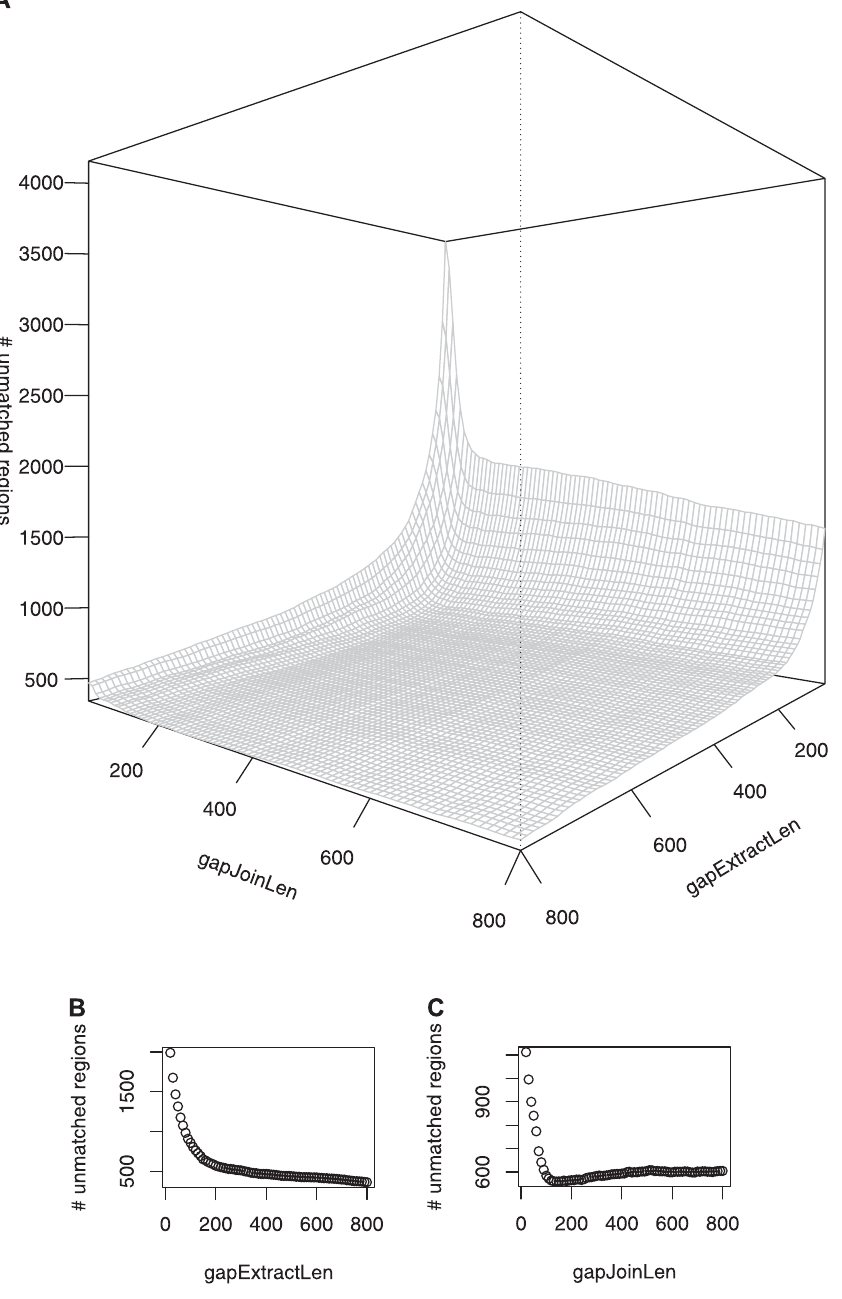
Figure 7. Number of Detected Unmatched Regions in Step 3 of the Preprocessing Phase (see Figure 3A and Preprocessing Phase: Building a Comprehensive Table of Similar Segments) in the Comparison of S. flexneri 2457t and S. typhi ty2 as a Function of gapJoinLen and of gapExtractLen (A) A 3-D graph of the function. (B) A projection of the graph as a function of gapExtractLen (horizontal axis) when setting gapJoinLen ¼ 110. (C) A projection of the graph as a function of gapJoinLen (horizontal axis) when setting gapExtractLen ¼ 200. DOI: